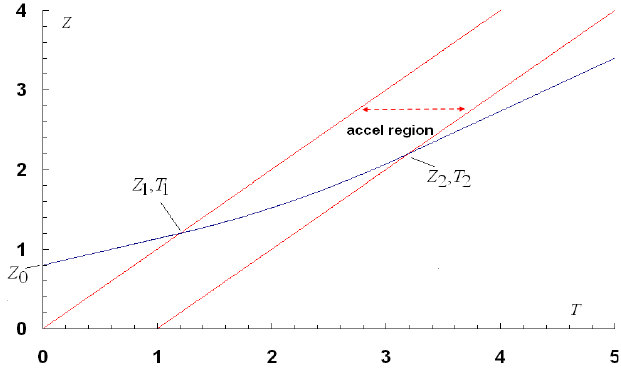
FIG. 16. (Color) Trajectory of a typical ion in the ‘‘snowplow mode.’’ The ion is located at the position z wave starts to propagate down the helical